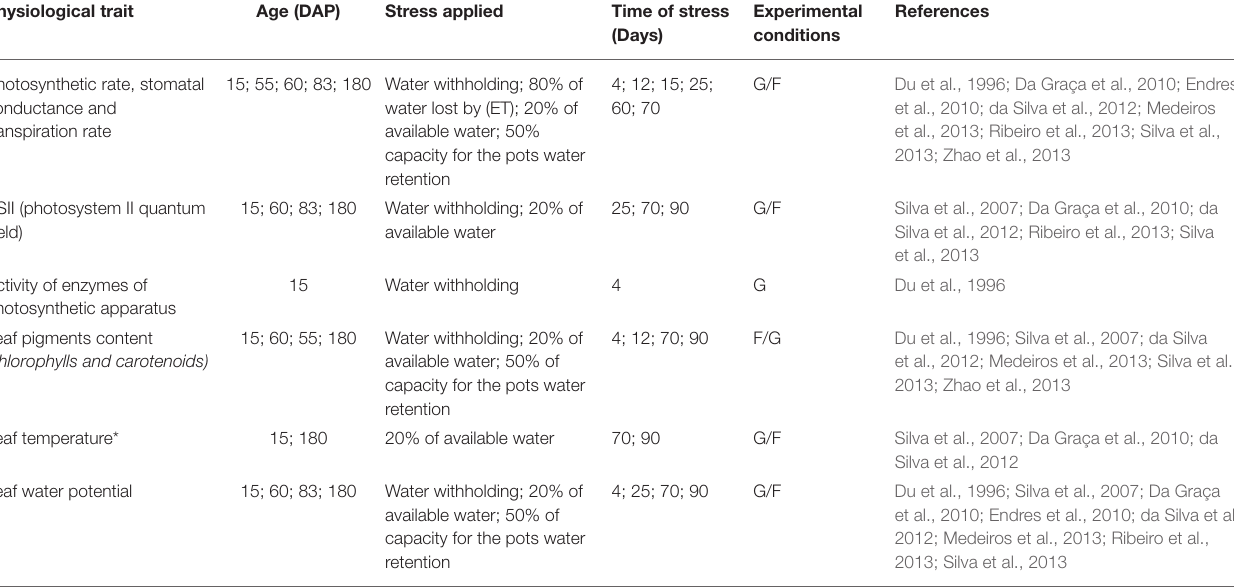
TABLE 2 | Physiological traits used to differentiate the degrees of drought resistance in sugarcane genotypes. Physiological